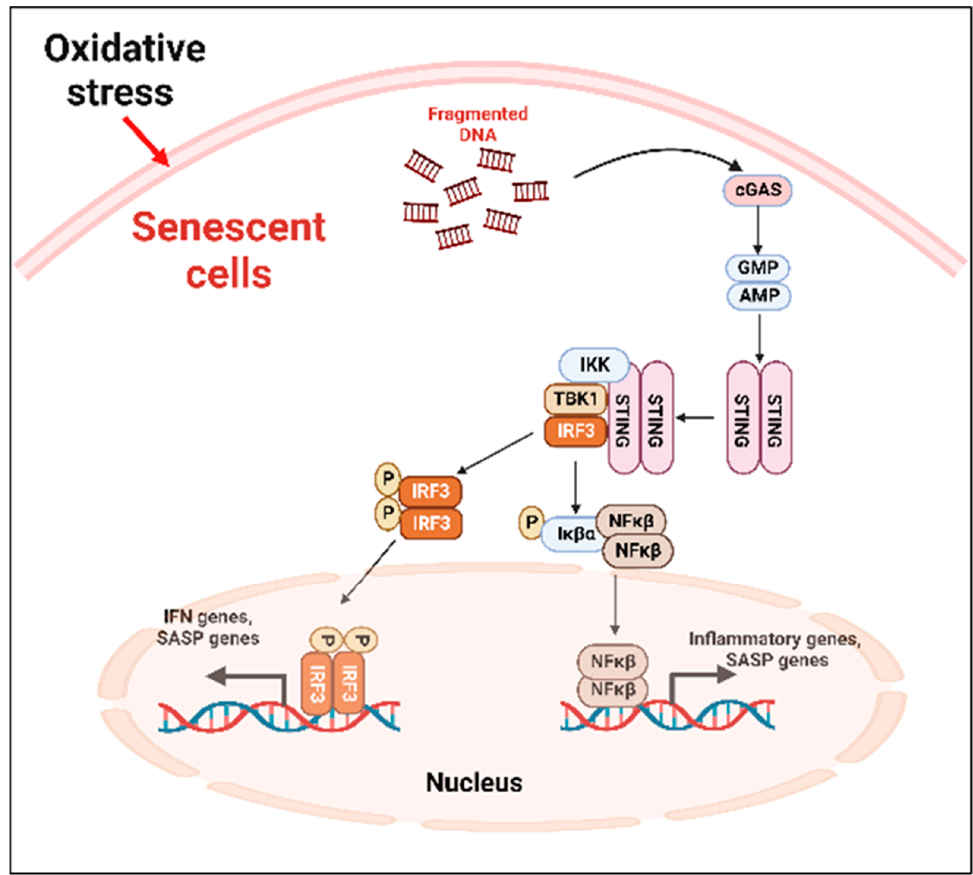
Figure 2. cGAS-STING-mediated cellular senescence. In response to oxidative stress, DNA fragments are released from the nuclei to the cytoplasm which are recognized by the cGAS, activating STING. The activated STING complex with TBK1 phosphorylates the transcription factor IRF3 and NF κβ . Activated NF κβ induces the transcription of proinflammatory SASP genes. cGAS: cyclic guanosine monophosphate (GMP)-adenosine monophosphate (AMP) synthase; STING: stimulator of interferon genes; TBK1: TANK-binding kinase 1; NF κβ : nuclear factor ‘kappa-light-chain-en- hancer.